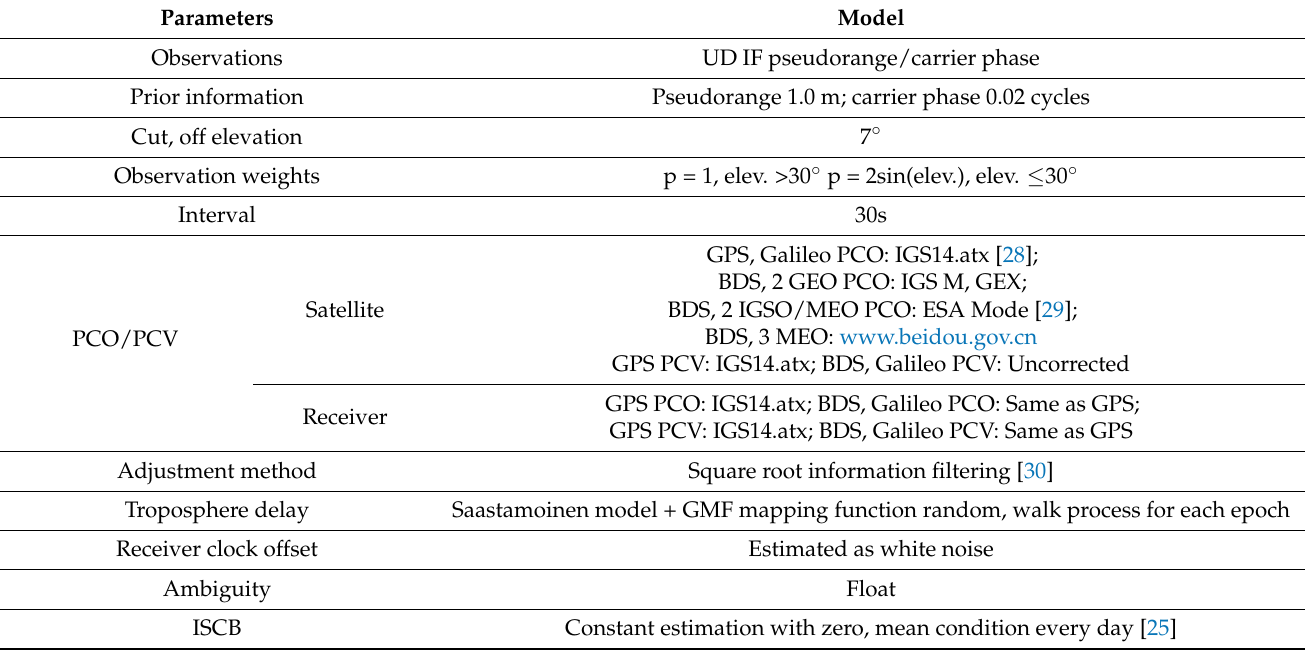
Table 3. Processing strategy, model, and parameters of the inter, satellite code bias (ISCB)